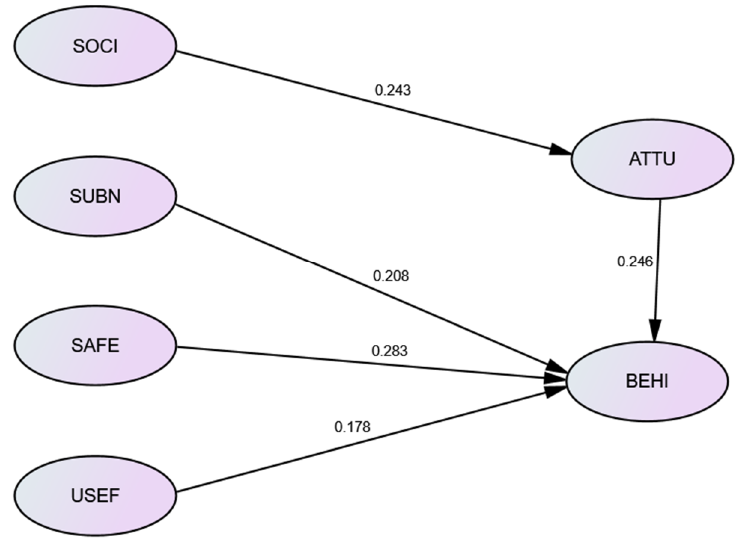
Figure 4. SEM statistic model. Table 7. Path analysis.